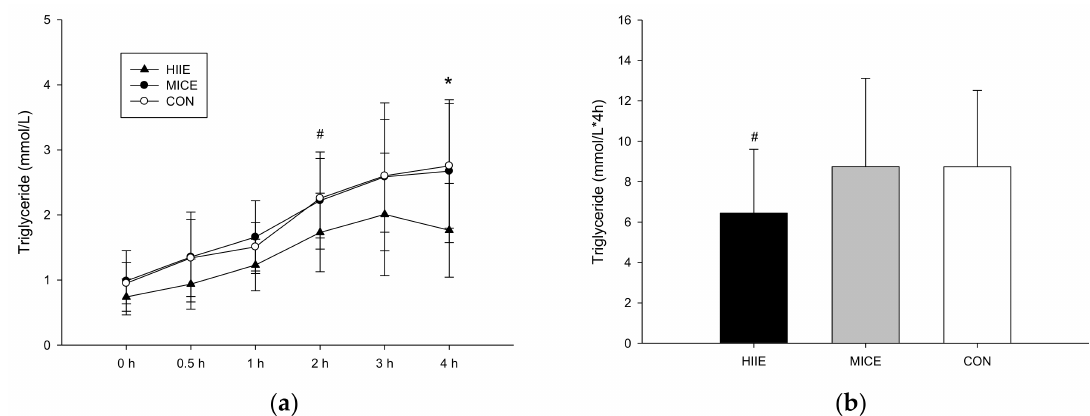
Figure 2. Plasma triglyceride (TG) concentrations over the 4 h during the postprandial period ( a ) and TG AUC ( b ). # Mean HIIE was significantly lower than MICE and CON after the high fat meal ( p < 0.05). * Mean HIIE significantly was higher than CON ( p = 0.028).